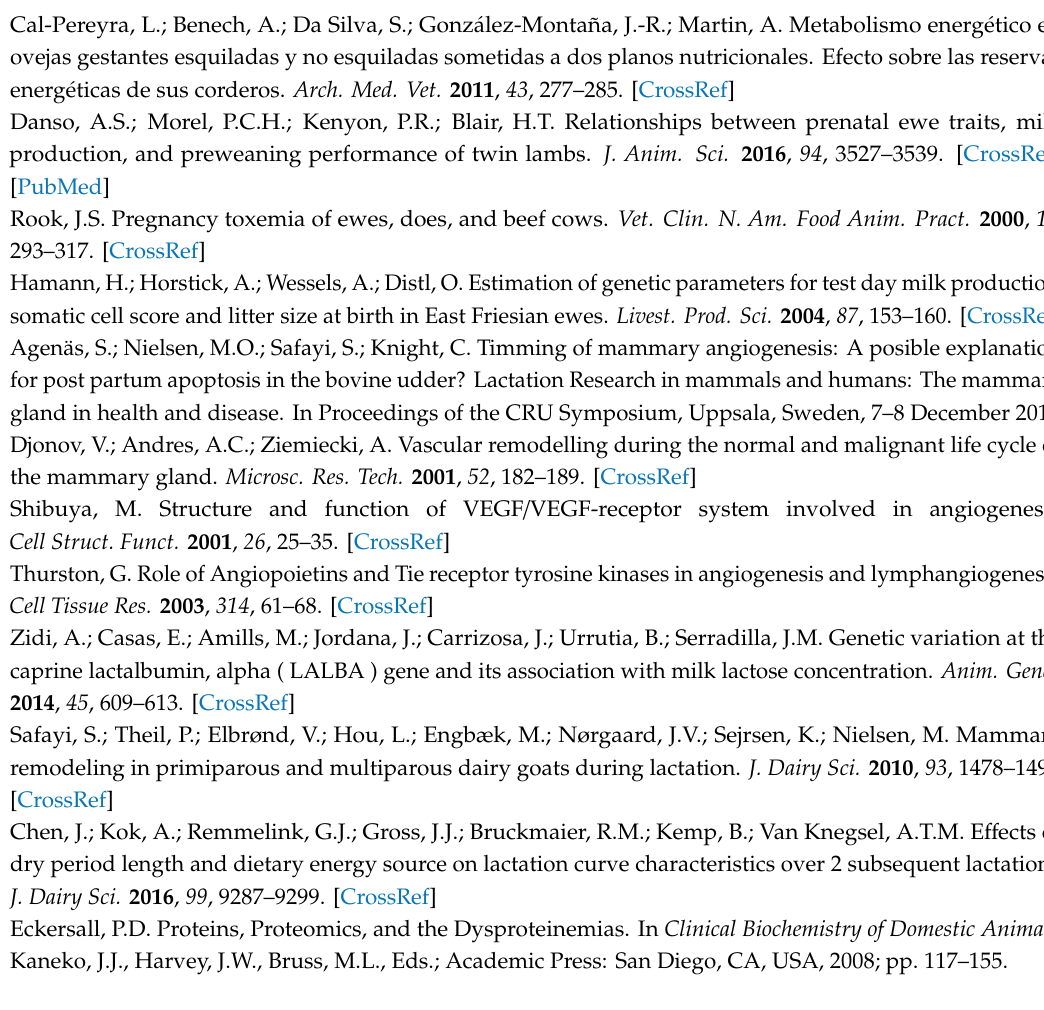
Table S1. E ff ect of the type of pregnancy (twin or single lamb) on lamb performance including LBW (Kg) and ADG at 35d, at weaning and also at 30 and 60 days after weaning (LSM ± SEM) 1,2,3,4,5 , Table S2. Final e ff ect of the type of gestation (twin or single lamb) on the transcriptional expression of ACC, FAS, SCD1 and SREBP1c, LPL and PPAR γ in Longissimus dorsi muscle in lambs from weaning (70 days) to 30 and 60 days after weaning (LSM ± SEM), Table S3. E ff ect of the type of pregnancy on the transcriptional expression of genes associated to angiogenesis inside the mammary gland (LSM ± SEM), Table S4. E ff ect of the type of pregnancy on the transcriptional expression of genes associated to cell turnover / lactogenesis inside the mammary gland (LSM ± SEM), Table S5. E ff ect of the type of pregnancy and the measuring time related on plasma metabolic response in ewes (LSM ± SEM) 1,2,3,4,5 , Table S6. E ff ect of the type of pregnancy and the measuring time related on plasma metabolic response in lambs (LSM ± SEM) (TP; n = 6); (SP; n = 7) 1,2,3,4